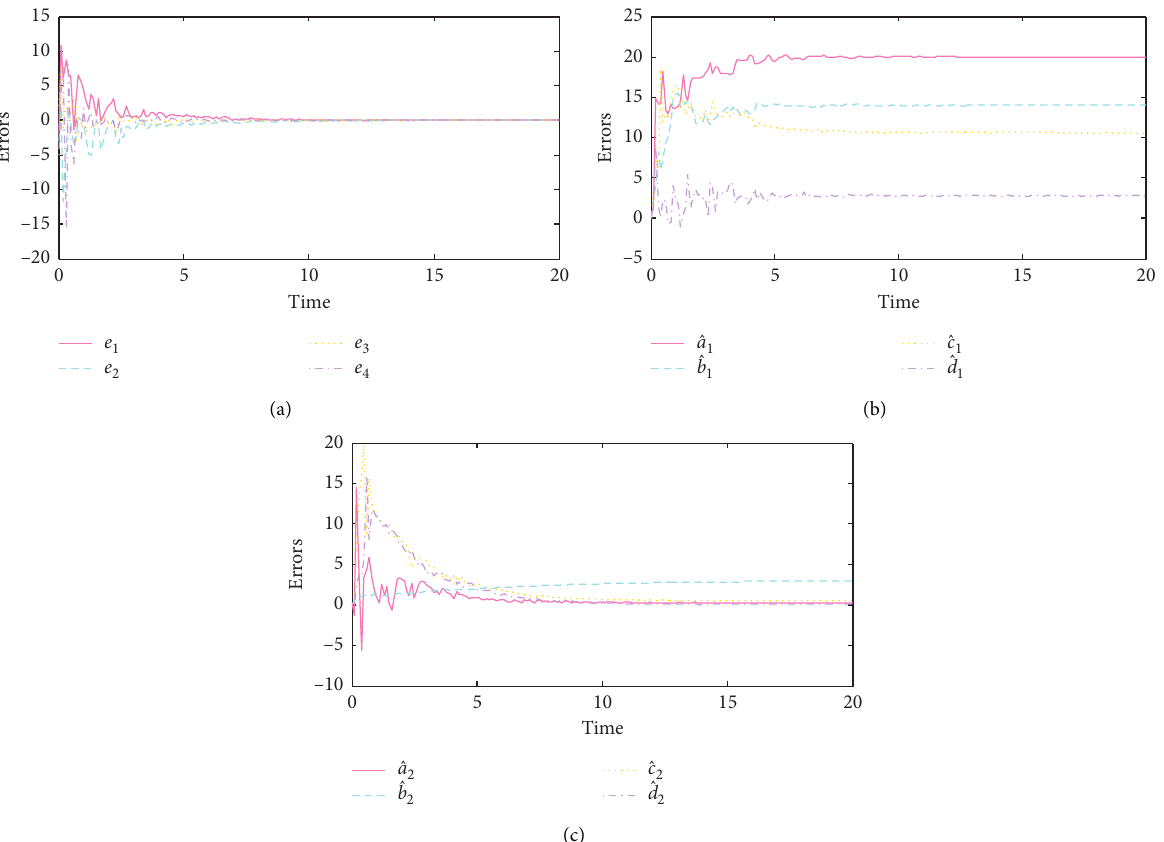
, x ,x ) space; (b) projection in ( x 1 2 3